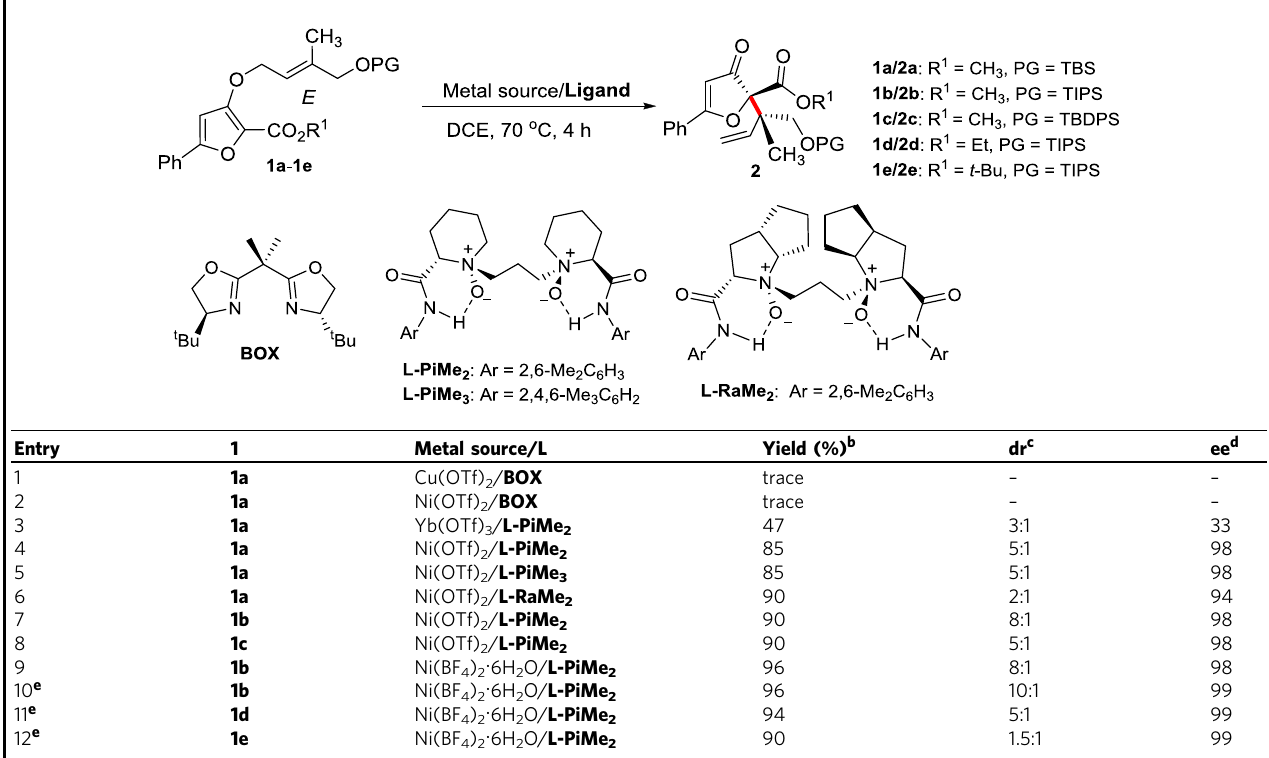
Table 1 Optimization of the reaction conditions a